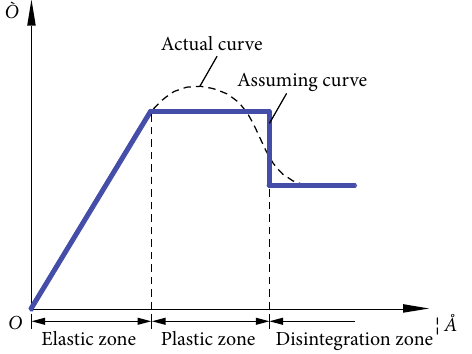
Figure 3: Stress – strain curves of rock deformation failure and zoning plan.